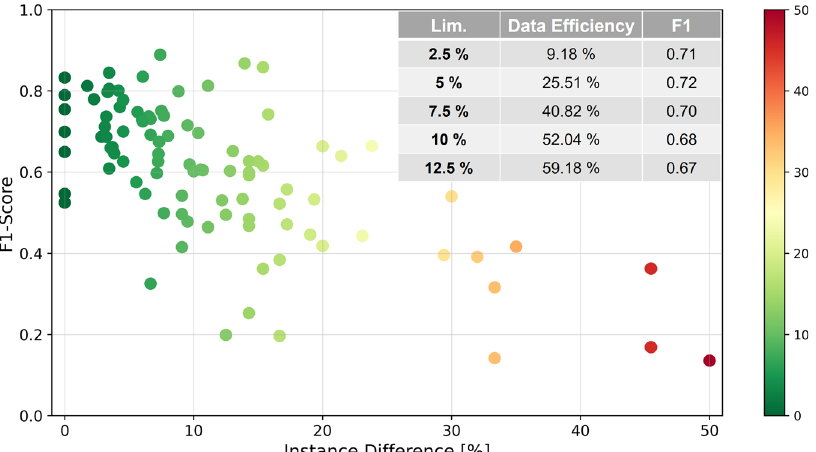
Fig. 8 F1-score in dependency of the instance difference (ID) given in % for the Pd/C system. A table summarising selected ID values with respective data ef fi ciency and calculated F1-scores is